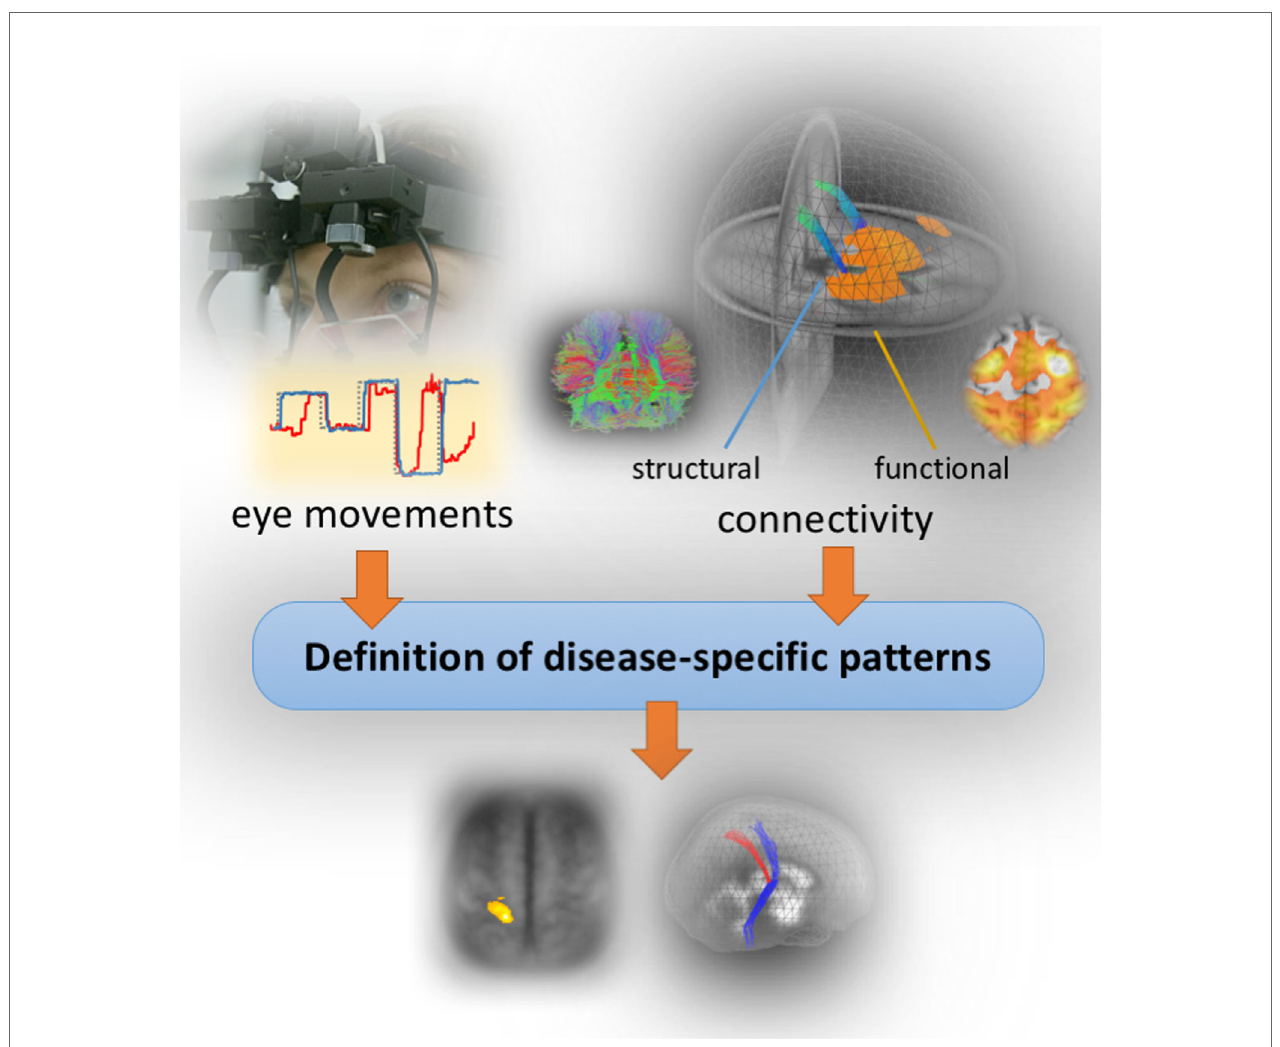
FiGURe 2 | Concept of the bimodal study design. Structural and functional brain mapping of eye movement control by combining video-oculographically eye movements recordings (left upper panel) with structural and functional MR imaging data (right) in order to define disease-specific